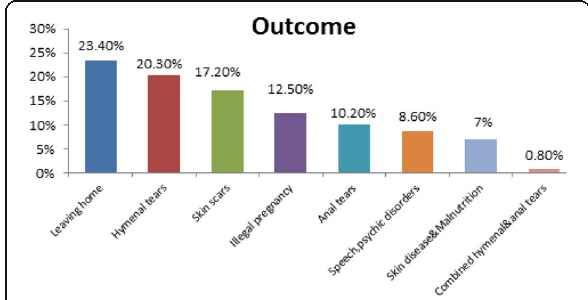
Fig. 5 Distribution of studied cases according to